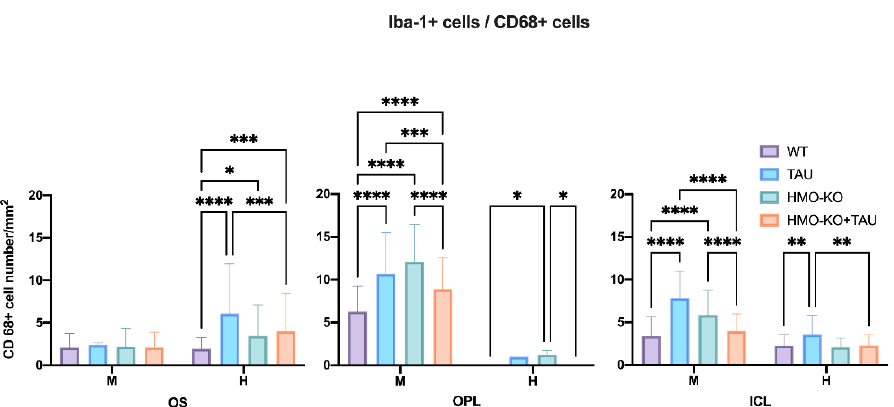
Figure 7. Number of Iba-1+/CD68+ microglial cells per retinal area of 0.1502 mm 2 in the different retinal layers in each of the study groups, expressed as mean value ( ± DS). Two-way ANOVA; H: high phagocytic capacity; M: mean phagocytic capacity; * p < 0.05, ** p < 0.01, *** p < 0.001, **** p < 0.0001. Number of retinas used in the experiment: WT n = 6, HMO-KO n = 6, TAU n = 6, and HMO-KO+TAU n = 6.